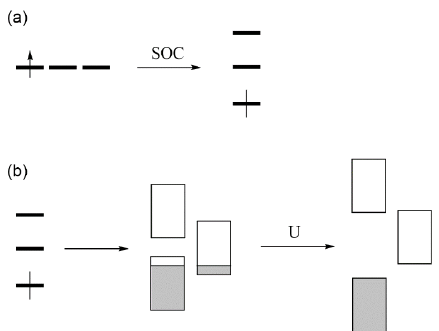
Figure 17. ( a ) The split of the t 2g level of an OsO 6 octahedron by the SOC of Os 7 + . ( b ) The formation of the t 2g block bands of Ba 2 NaOsO 6 from the t 2g level split by the SOC, leading to a magnetic metallic state (left), which become magnetic insulating by the spin polarization arising from the on-site repulsion of Os 7+ (right). Note that, under SOC, there is no distinction between up-spin and down-spin electrons.